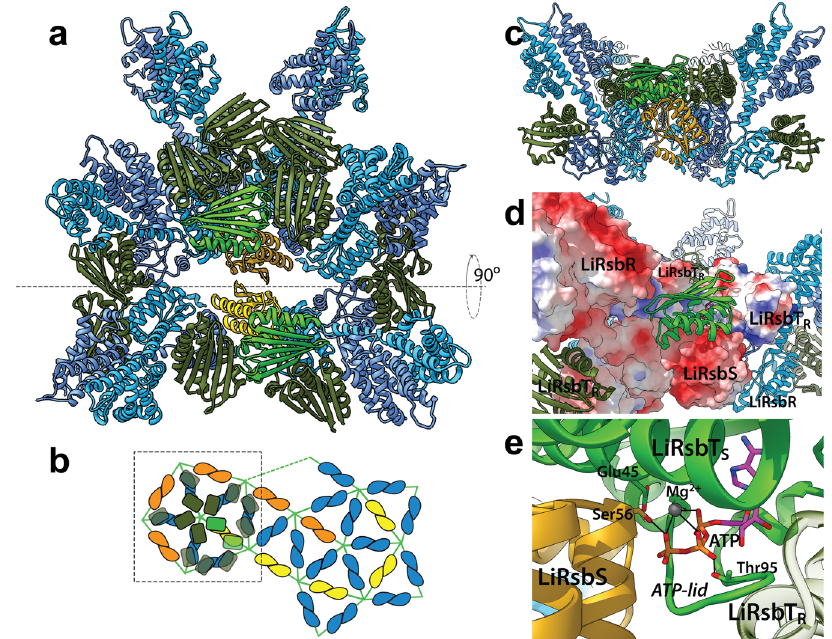
Fig. 6 Proposed assembly of the functional hetero-triangular Li RsbRS complex with docked Li RsbT. a View on the triangular faces of Li RsbRS (RsbR in blue and RsbS in yellow colors), and with Li RsbT homology models (shown in dark green color docked to Li RsbR and in light green color docked to Li RsbS). b Two-dimensional representation of the pentagonal and triangular faces in the STAS icosahedron colored according to ( a ). The dashed box indicates roughly the composition shown in ( a ). c Sideview (as indicated by the gray, dashed line in a ) on the Li RsbRS – RsbT assembly. In this assembly, only the Li RsbT bound to an Li RsbS can dissociate from the complex; Li RsbTs bound to Li RsbRs are sterically con fi ned by the linker helices. d Vicinity of the Li RsbT S (bound to Li RsbS, light green) binding pose shown as surface colored according to the electrostatic potential. The Li RsbT-binding site is created by equal contributions of one Li RsbS and two Li RsbTs, some contact to the sensory domain of Li RsbR is also feasible. e Vicinity of ATP in the proposed Li RsbS – Li RsbT complex. The target Ser56 and the potential catalytic base Glu45 are indicated. In the proposed Li RsbRS – RsbT assembly the ATP-lid is stabilized by the interaction with a neighboring Li RsbT R (bound to Li